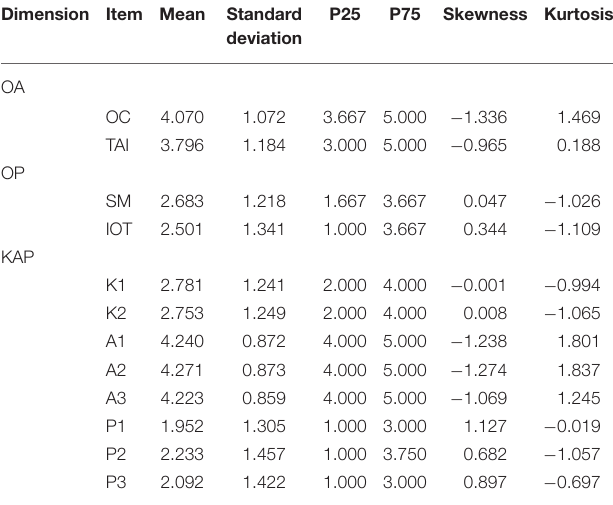
TABLE 3 | Organizational atmosphere, organizational practice, and physicians’ CEUS diffusion and utilization of knowledge, attitude, and practice (KAP) scores. Dimension Item Mean Standard